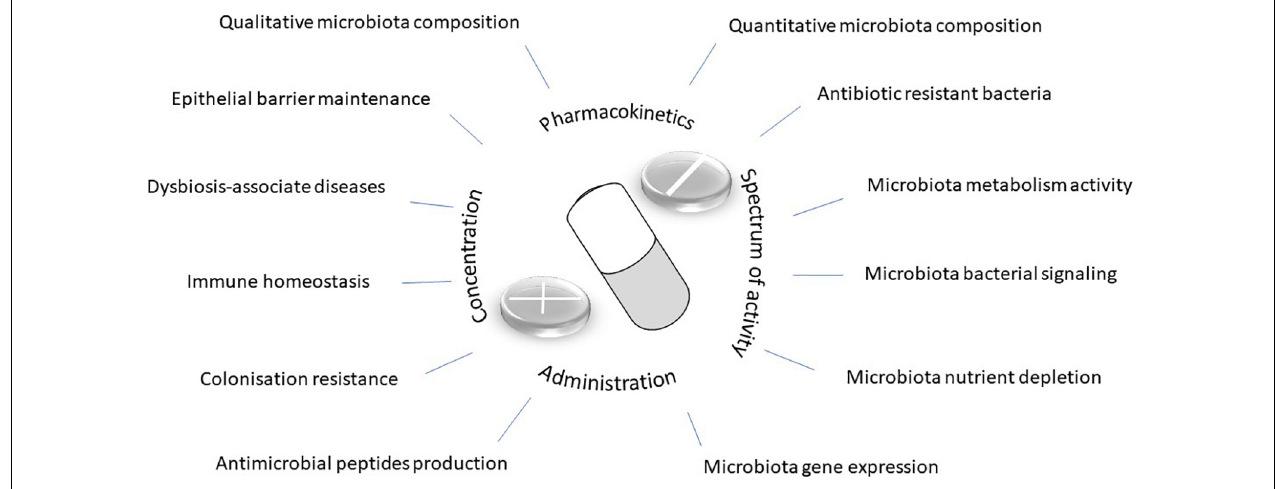
FIGURE 1 | Antibiotic